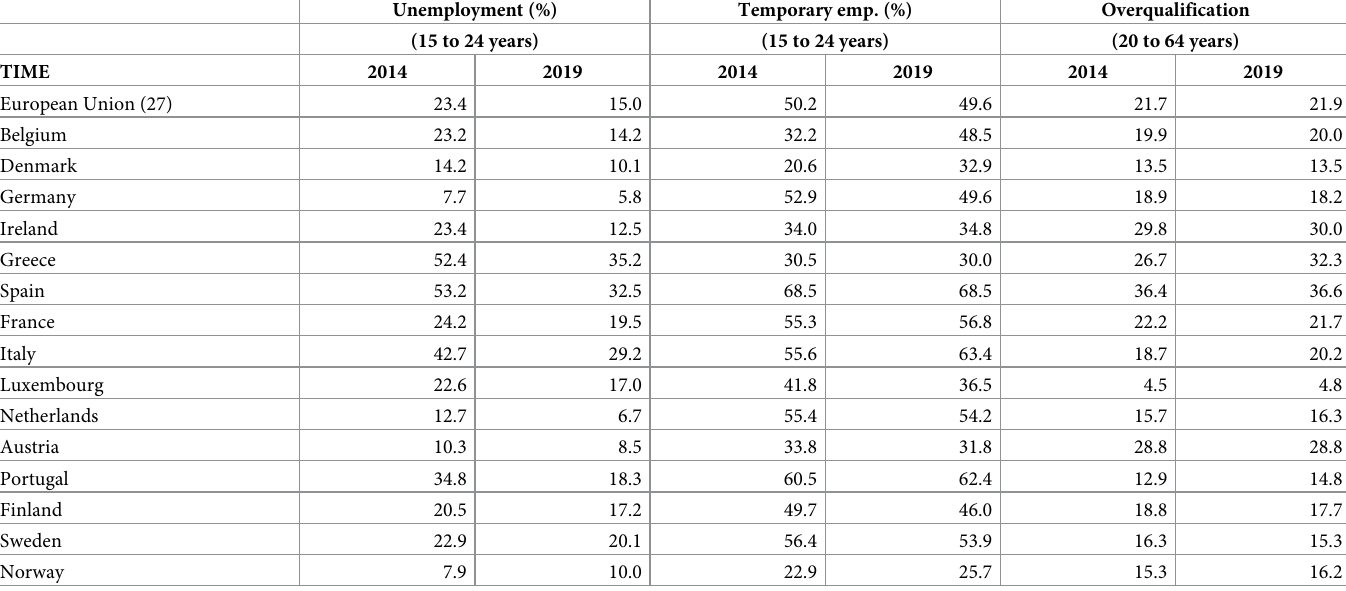
Table 1. The European labor market during the Great